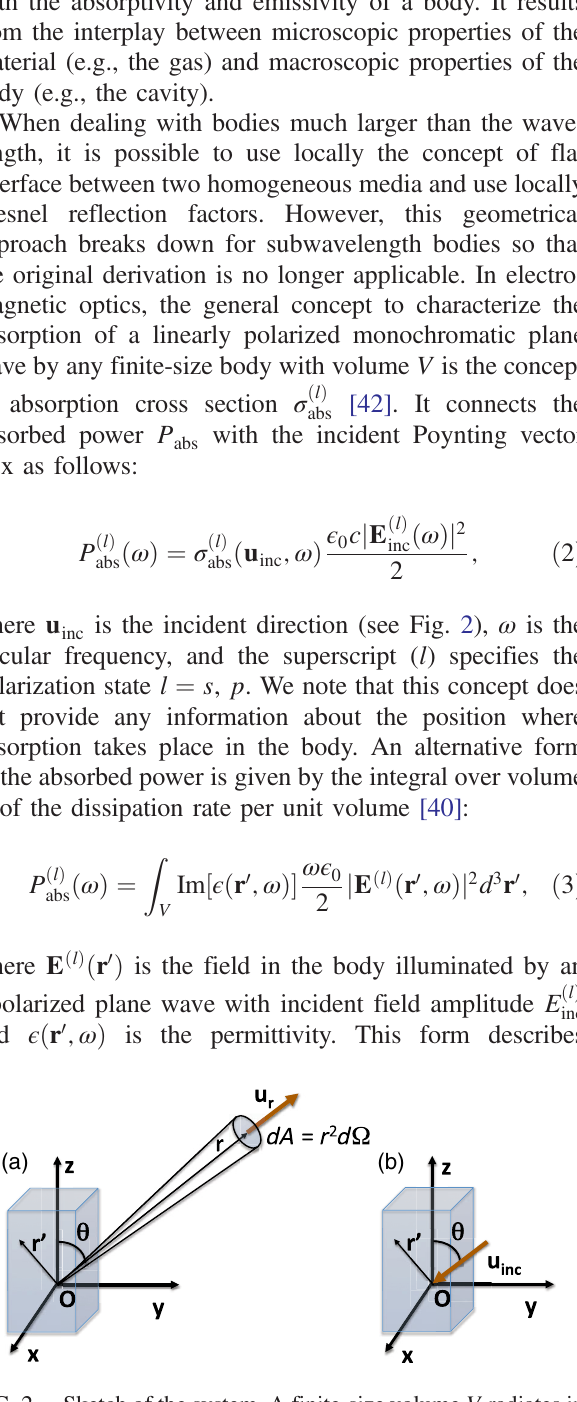
FIG. 2. Sketch of the system. A finite-size volume V radiates in the solid angle d Ω subtended by the surface dA